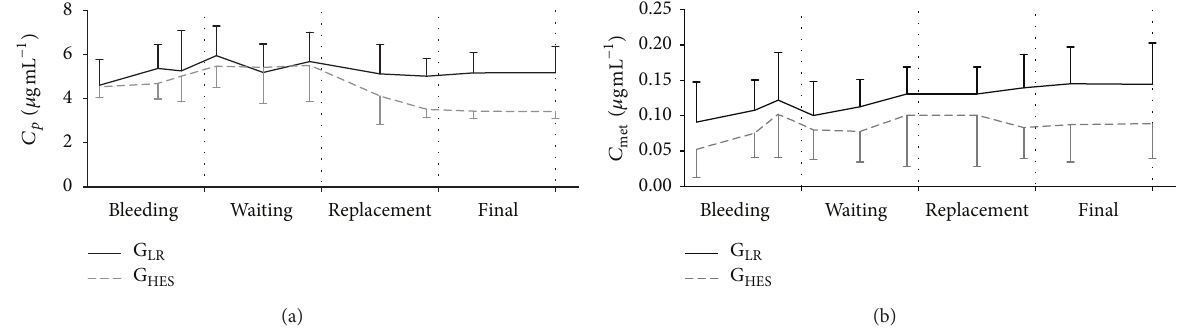
— 𝜇 g/mL) during the four phases of the study. met